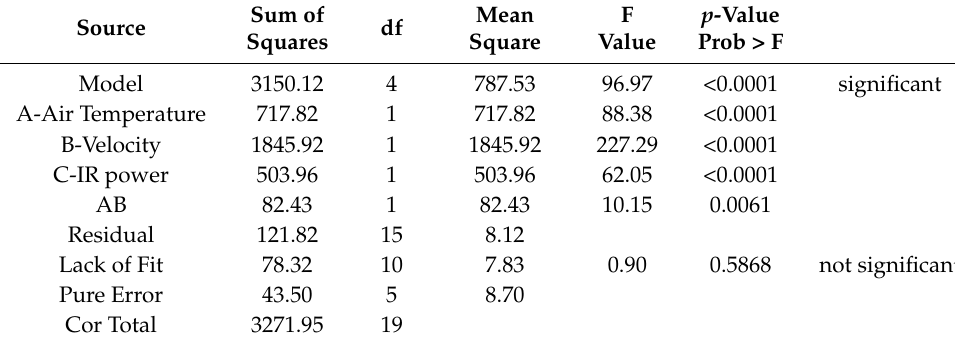
Table 6. Analysis of variance for SEC response using RSM.